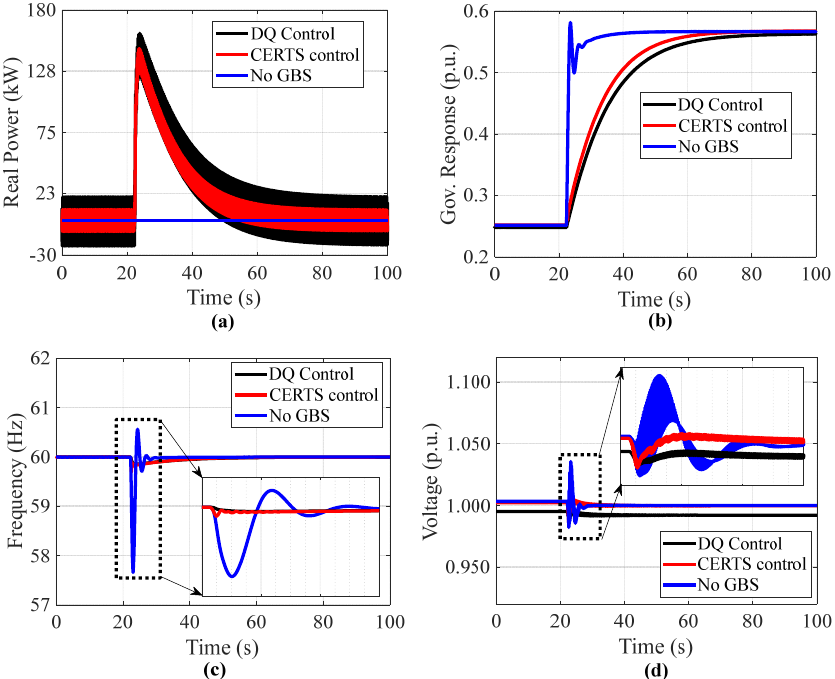
Figure 10. Comparison of Two Grid-Forming Inverter Models under a Loss of Wind Scenario. ( a ) output power; ( b ) governor response; ( c ) systems’ frequency with magnified transient response; ( d ) output voltage of phase C with magnified transient response.